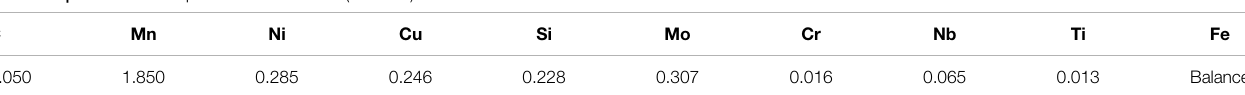
TABLE 1 | Elemental composition of X80 steel (mass %).